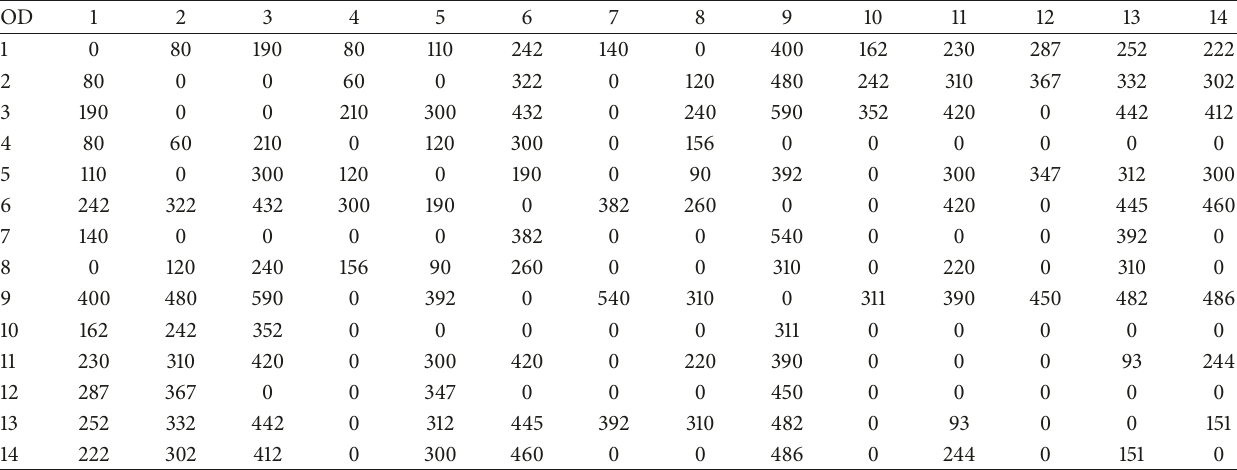
Table 6: Distance between OD pair for hub-spoke service network with stopping station (km).